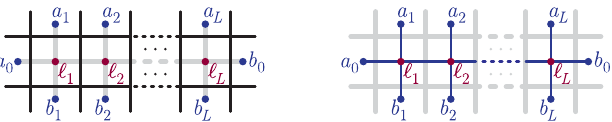
Figure 2. The L -loop traintrack integral and its dual